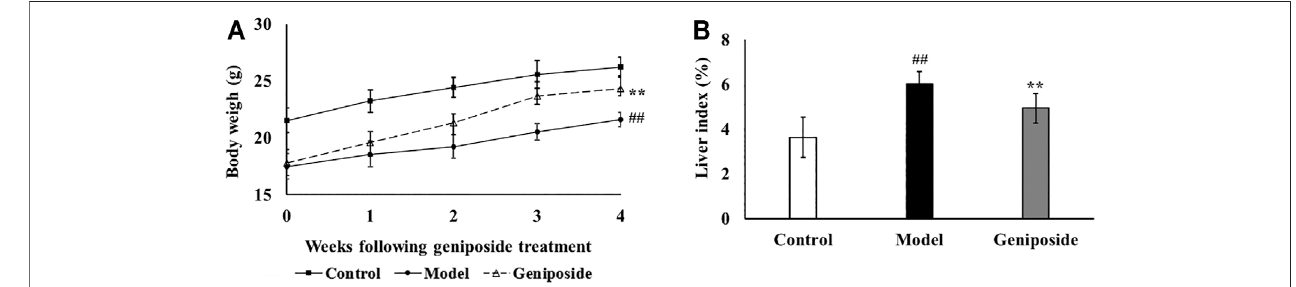
FIGURE2 | Geniposide treatment increases body weight and liver index. (A) Body weight of 3groups. (B) Liverindex of3groups. Control, model, and geniposide groups ( n (cid:2) 10 per group). ## p < 0.01, Model group vs. Control group; p p < 0.05 and pp p < 0.01, Geniposide group vs. Model group.